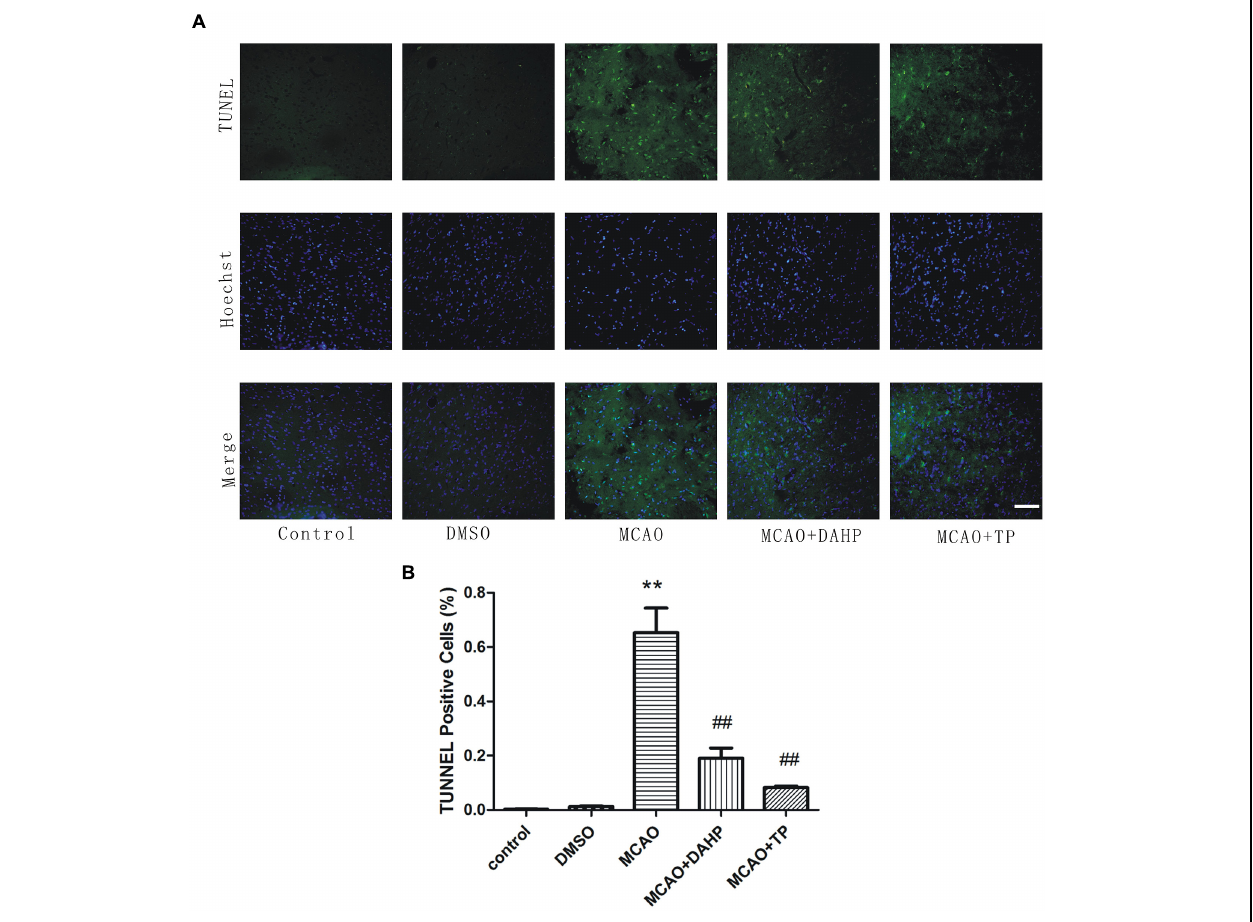
FIGURE 3 | Detection of neuronal apoptosis. (A) TUNEL staining was used to identify apoptotic cells. (B) TUNEL positive cells were counted using Meta-Morph program. TUNEL positive cells show the quantitative analysis data. Data are expressed as mean ± SD, ∗∗ P < 0.01 vs. control group; ## P < 0.01 vs. MCAO group.